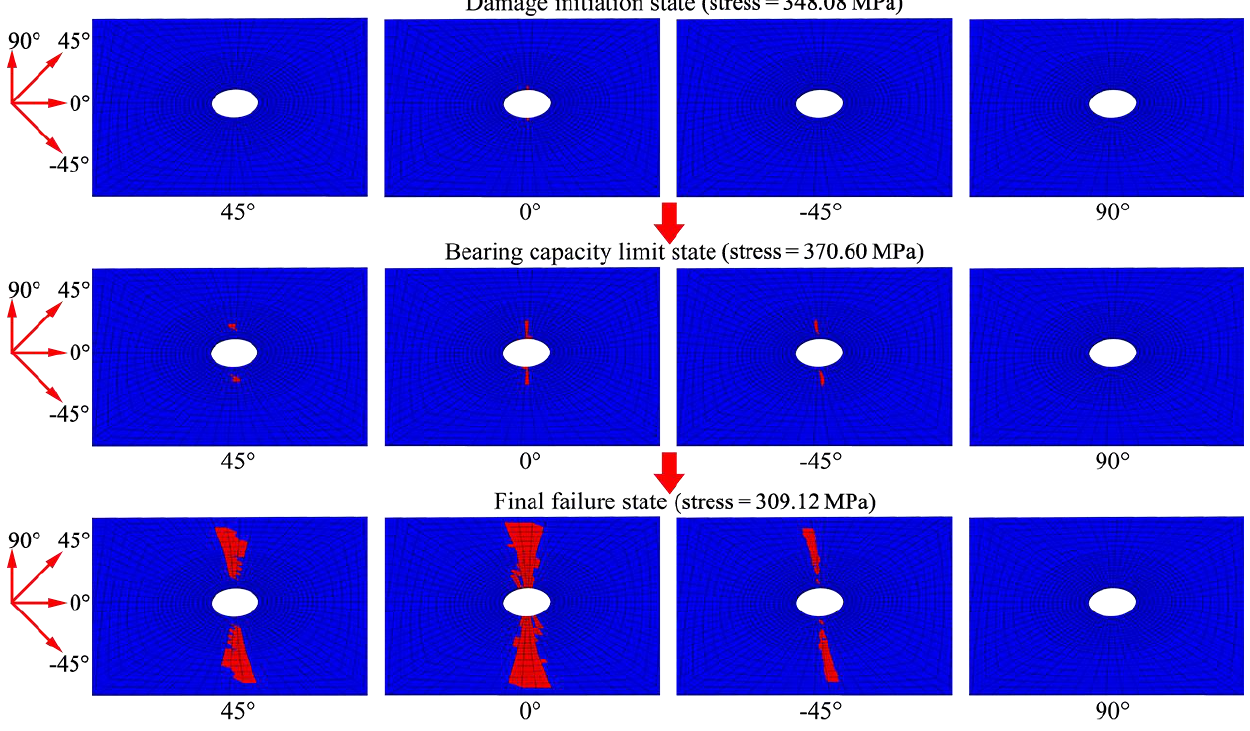
Figure 8. Illustration of fibre damage evolution at four plies of the second sub-laminate in different loading states.